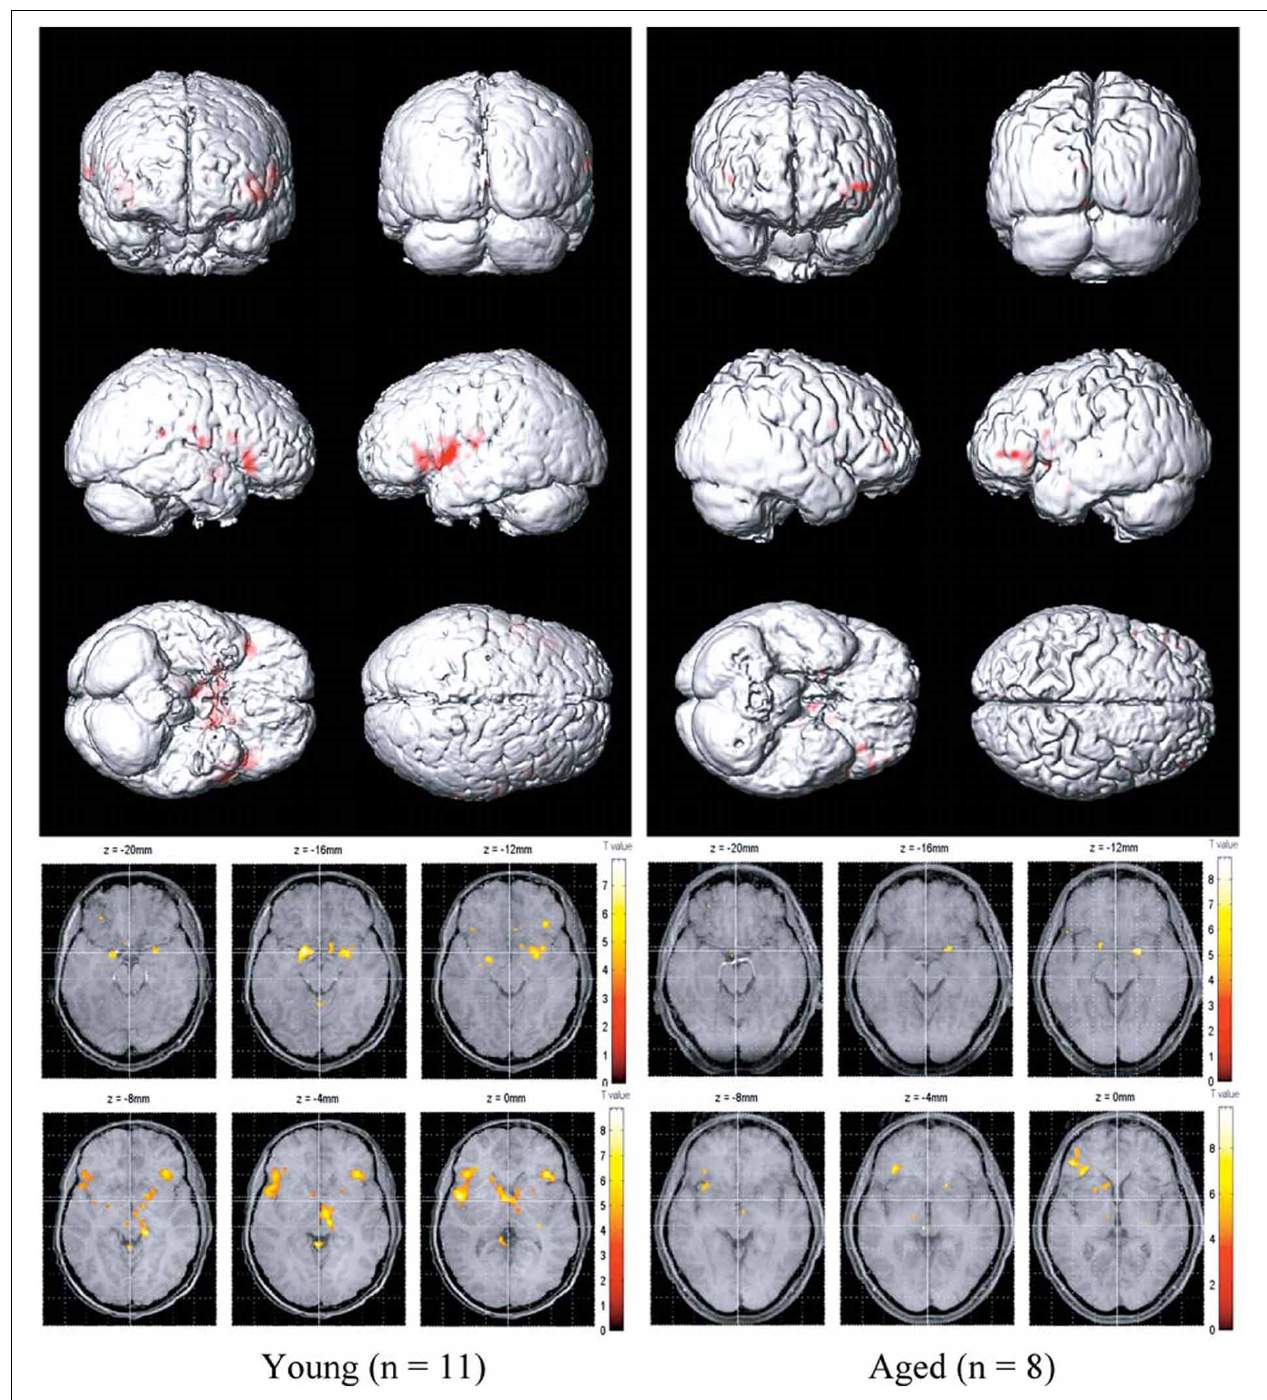
FIGURE 13 | Olfactory functional magnetic resonance imaging (fMRI) activation maps from 11 younger (left; mean age = 23.9 years) and 8 older (right; mean age = 66.4 years) persons to lavender and